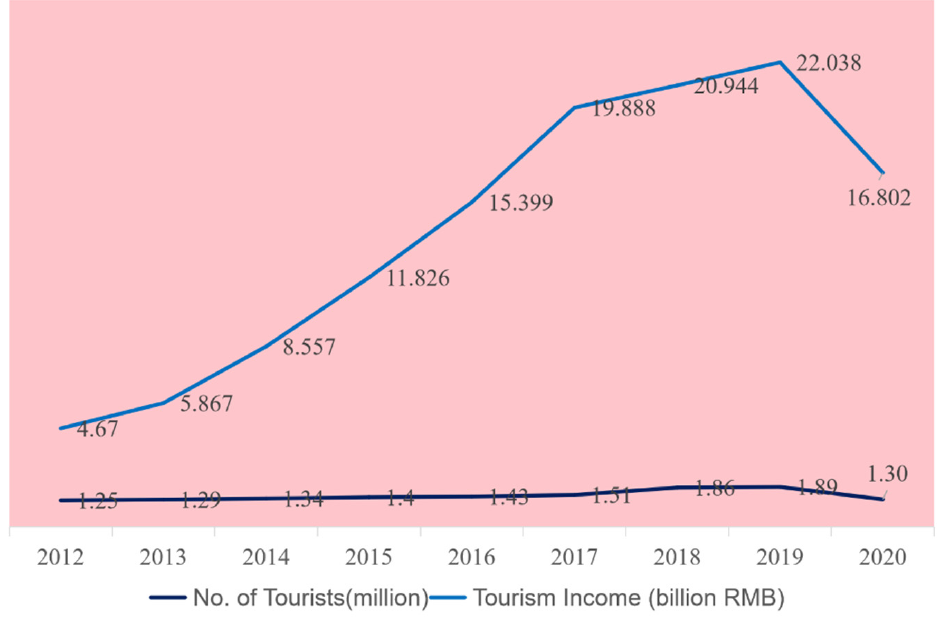
Figure 11. The number of tourists and amount of tourism income of Sanqingshan UGGp (2012–2020).